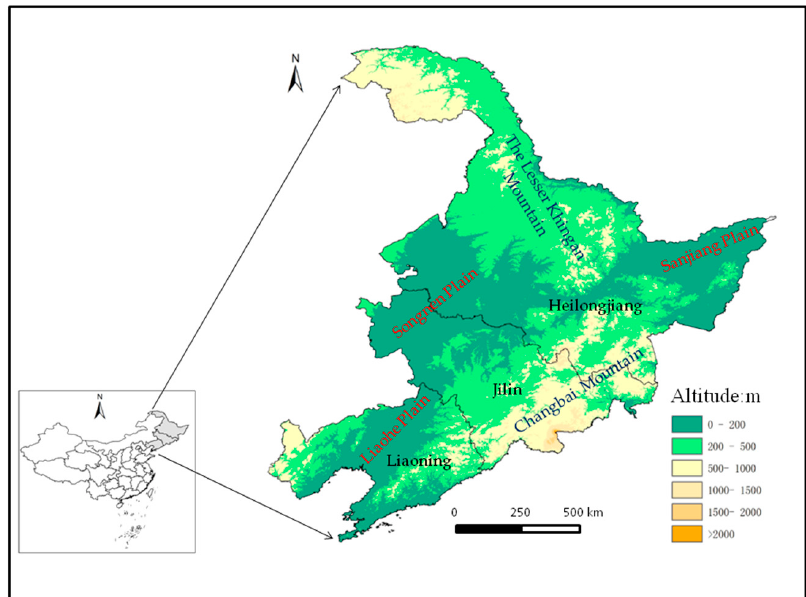
Figure 1. Position and topography of Northeast China.